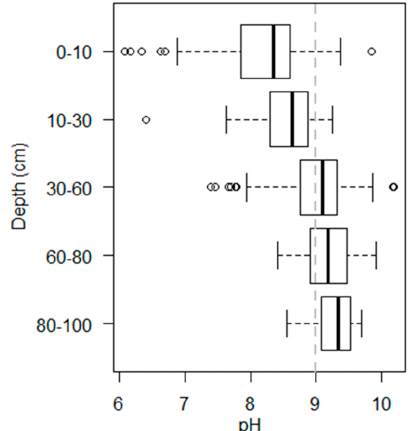
Figure 5. Boxplots of the distribution of soil pH (1:5 H 2 O) with depth for 110 soil cores taken from cropping fields at L’lara. Solid black lines inside boxes represent median values, and the dashed, vertical grey line indicates the pH (H 2 O) threshold of nine, deemed to have potential constraining e ff ects on crop